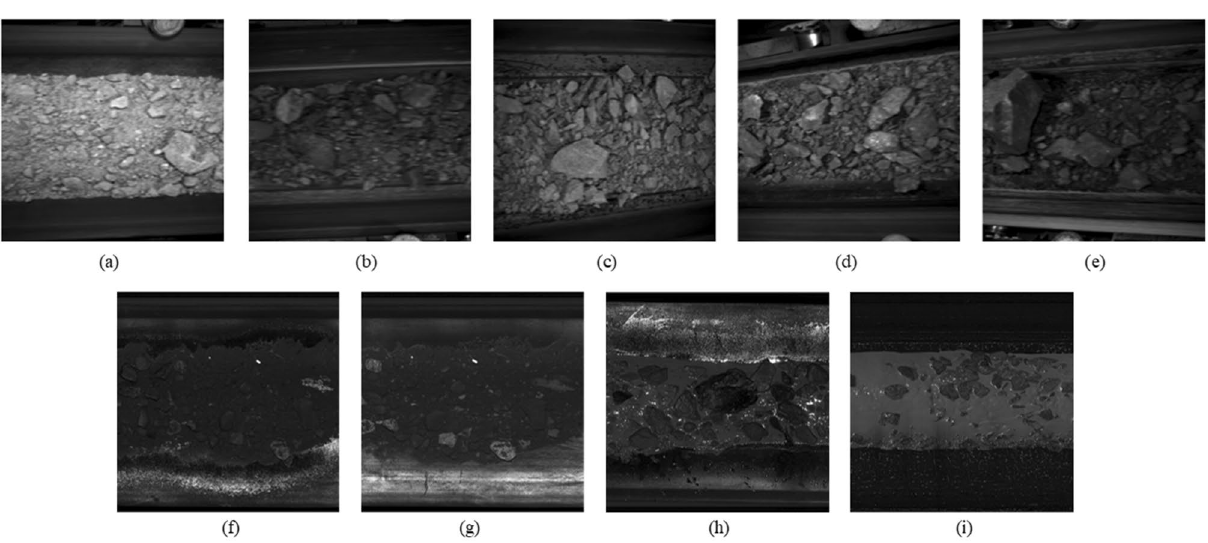
Figure 3. Datasets. ( a ) Granite porphyry (GP). ( b ) Conglomeratic sandstone (CS). ( c ) Argillaceous siltstone (AS). ( d ) Medium fine sandstone (MFS). ( e ) Silty mudstone (SM). ( f ) Tectonic breccia (TB). ( g ) Cryptoexplosive breccia (CB). ( h ) Argillaceous silty limestone (ASL). ( i ) Bioclastic limestone